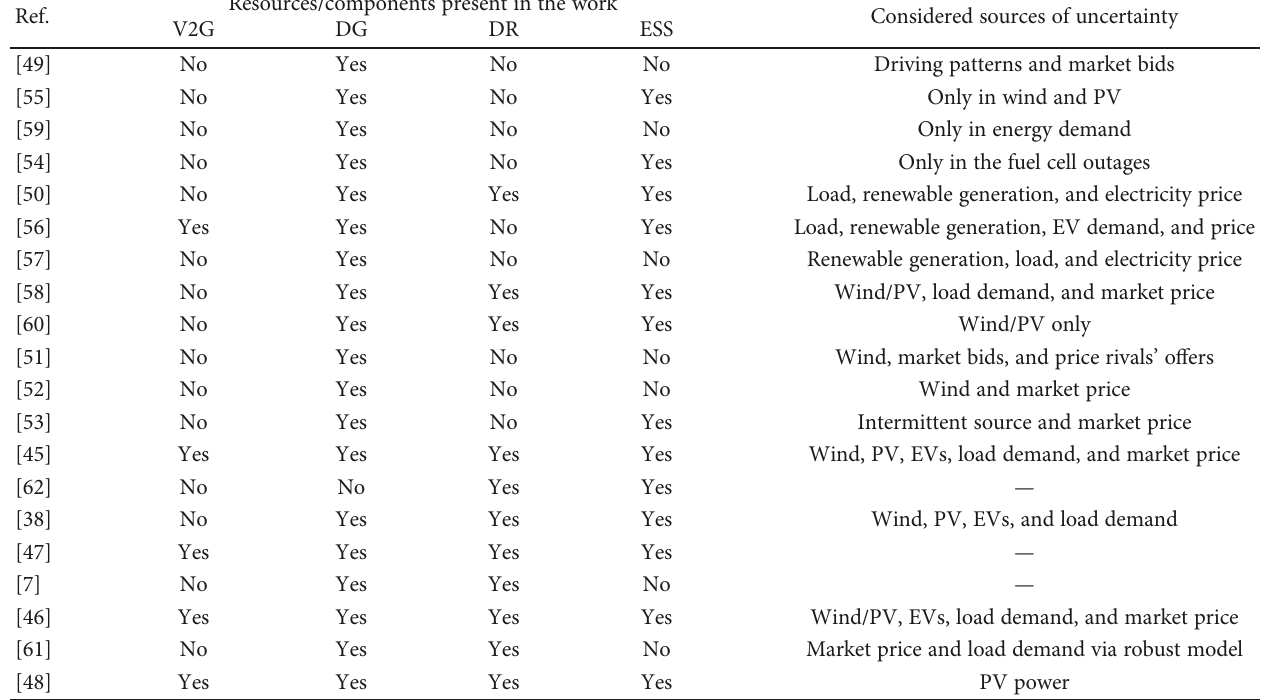
Table 2: Summary of energy scheduling models: resources and uncertainty sources. Ref.